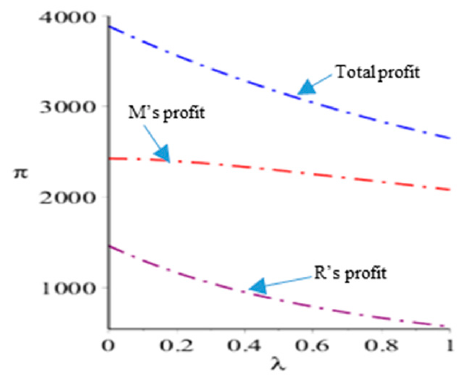
Figure 11. Impact of M’s fairness concerns on profits of both parties and system.